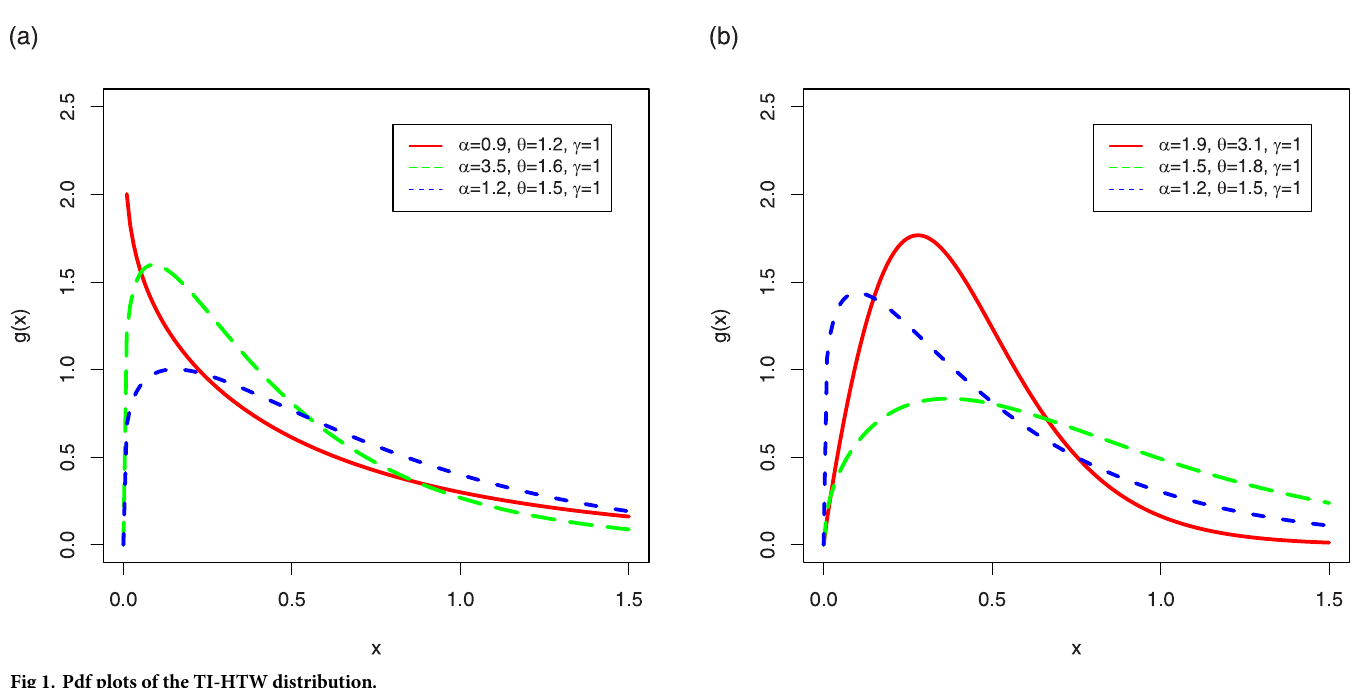
Fig 1. Pdf plots of the TI-HTW distribution.